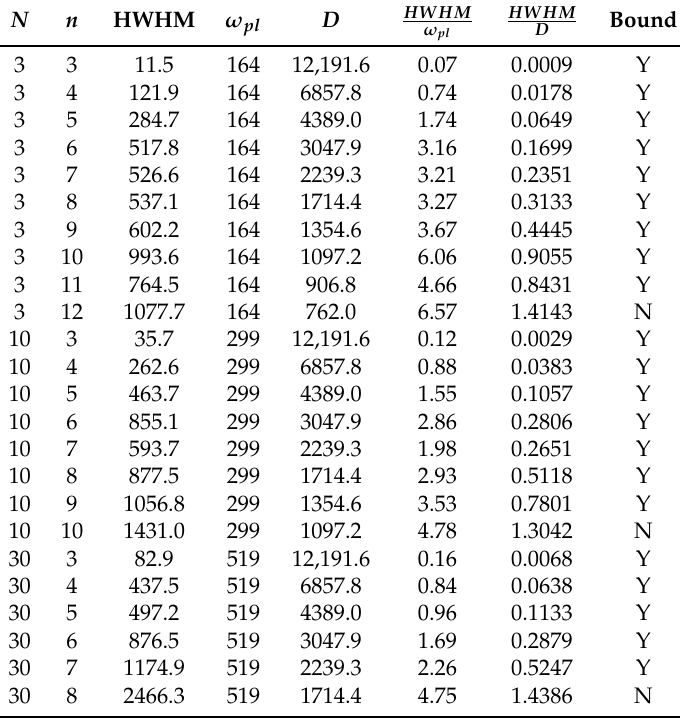
Table 4. Widths vs. plasma frequency ω pl and distance D to the continuum for CONVPST with strong collisions as a function of the upper level principal quantum number n . All energies are in cm − 1 and densities N in 10 17 e/cm 3 . The ’Bound’ column indicates whether the state is considered bound (Y) or not